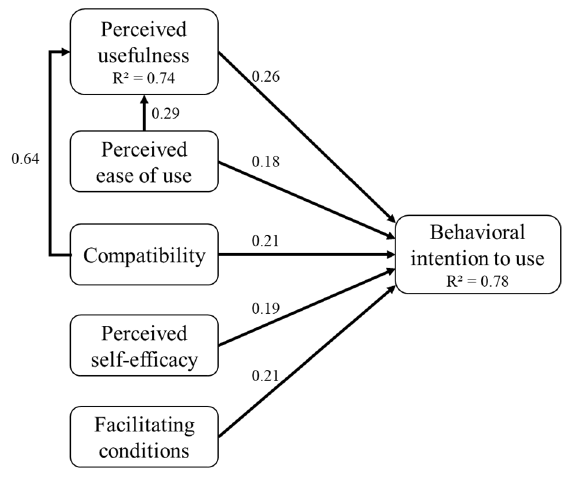
Figure 3. Illustration of the study’s empirical findings following the proposed model. Table 6. Variables’ direct, indirect, and total effects on dependent variables.